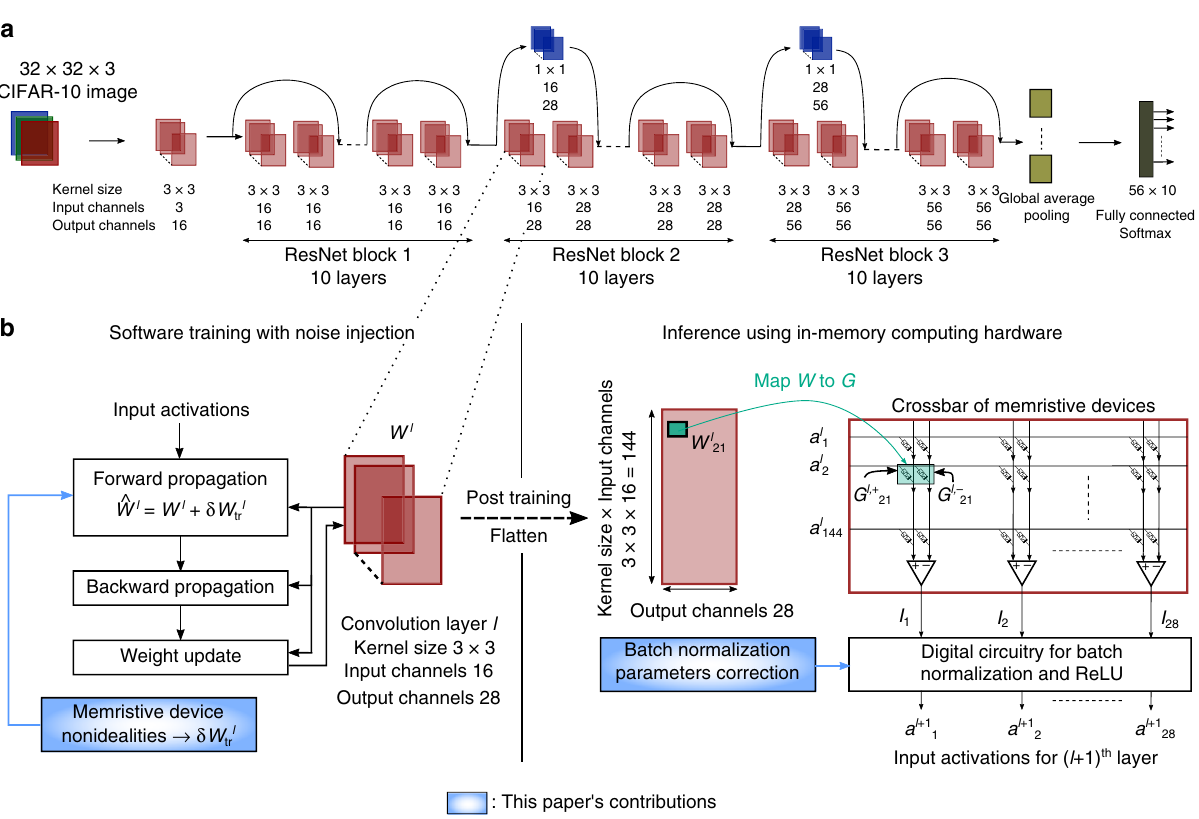
Fig. 1 Training and inference methodology. a ResNet-32 network architecture for CIFAR-10 image classi fi cation. The architecture of ResNet-32 used